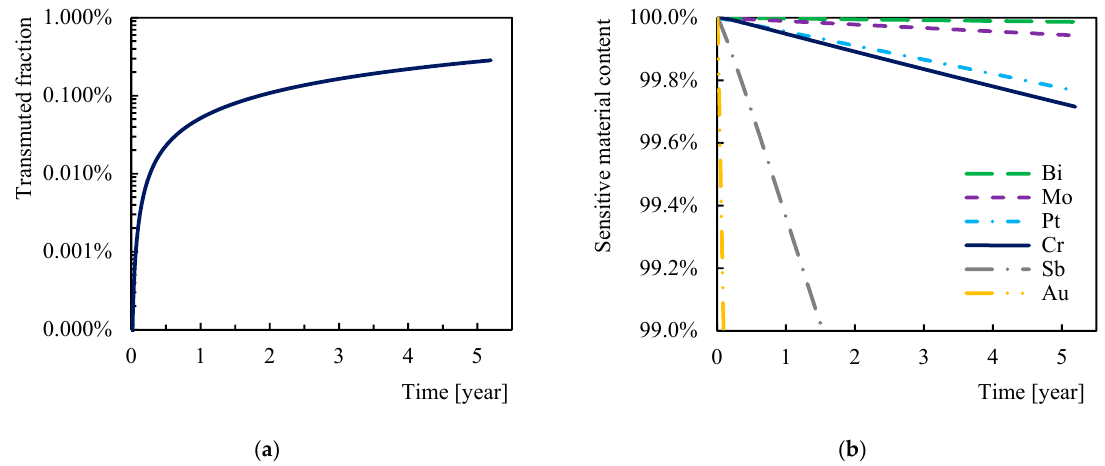
Figure 9. Transmutation of chromium under the neutron flux of the DEMO1 fusion power reactor during the operation Phase 1 (5.2 years): ( a ) Transmuted fraction of the chromium sensitive layer; ( b ) Comparison of the rate of transmutation of some metals and semi-metals.